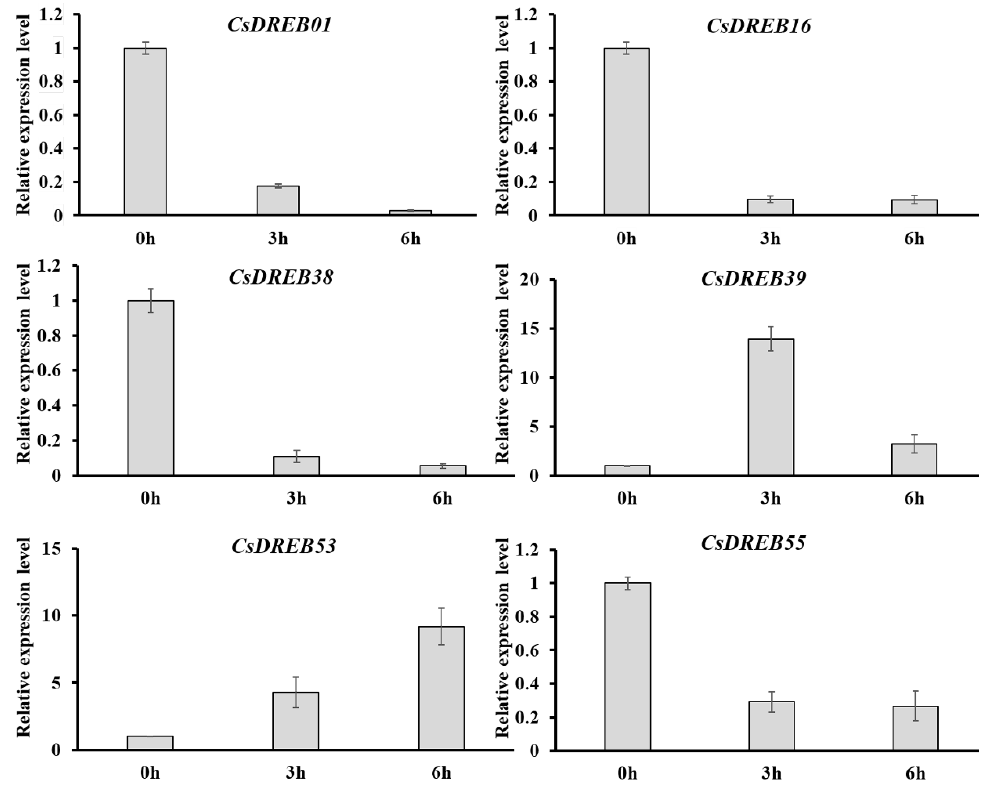
Figure 9. The qRT-PCR analysis of CsDREB genes under heat stress: The seedlings were kept at 42 ◦ C for heat stress, and leaf samples were collected at 0, 3, and 6 h. The value of each CsDREB gene at 0 h was normalized as ‘1.0’. The cucumber β - actin gene was used as an internal control, and three biological replicates were used for the gene expression analyses. Error bars represent the standard error (SE).